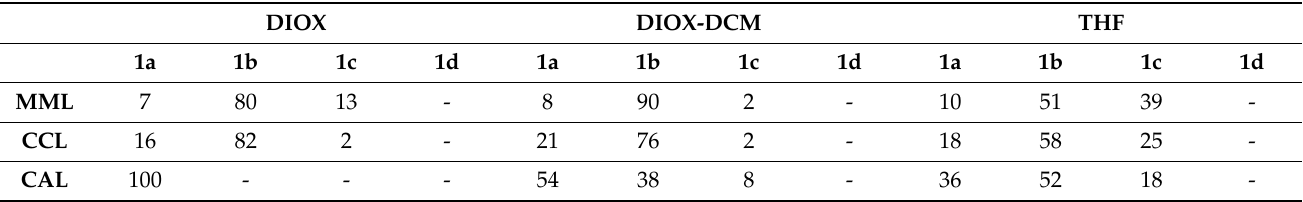
Table 1. Effects of solvent on the benzoylation of glycerol performed by MML, CCL and CAL. Percentage of glycerol ( 1a ), mono-( 1b ), di-( 1c ) and tri-benzoyl glycerol ( 1d ) present in the reaction mixture after 72 h.